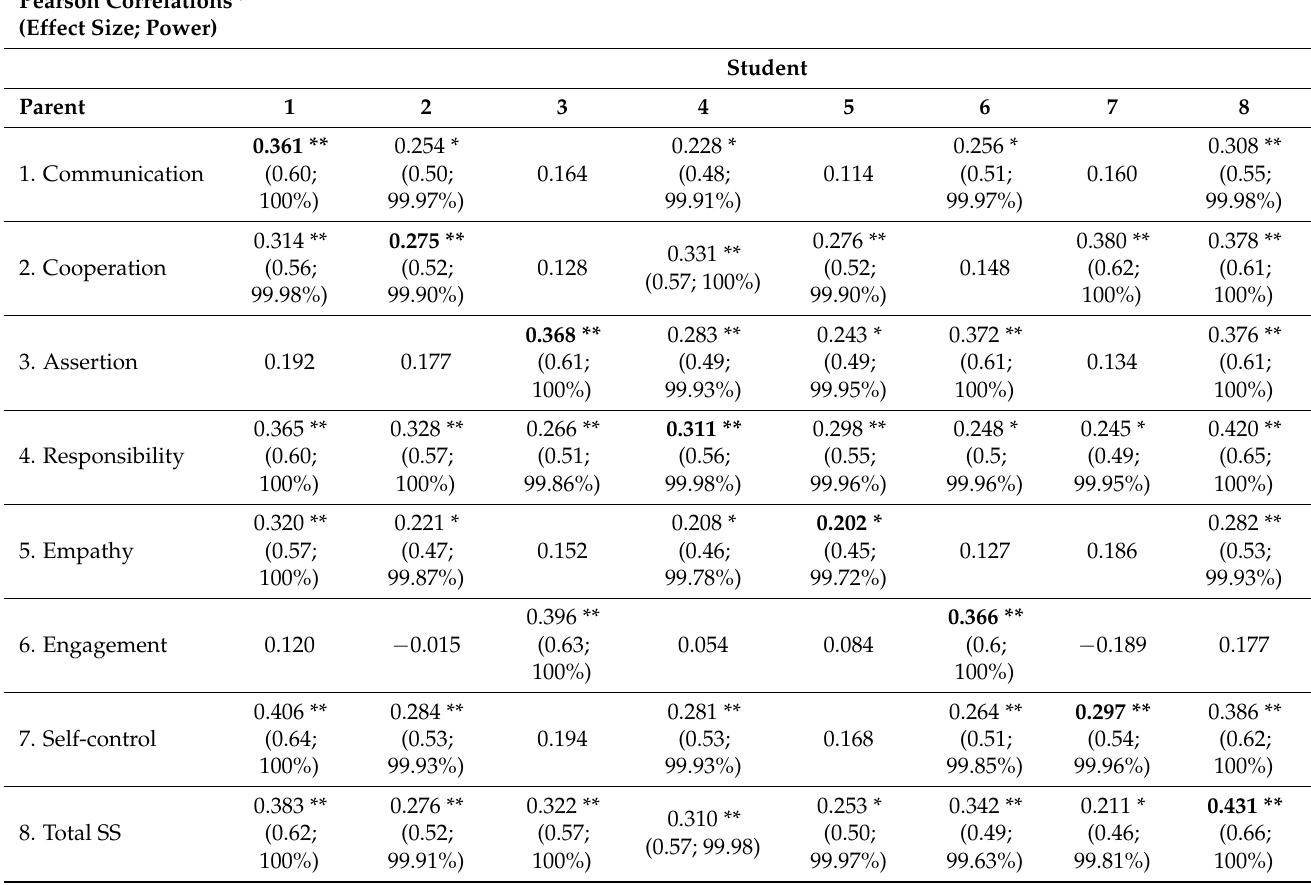
Table 4. Correlations for parent–student (subscales and total).